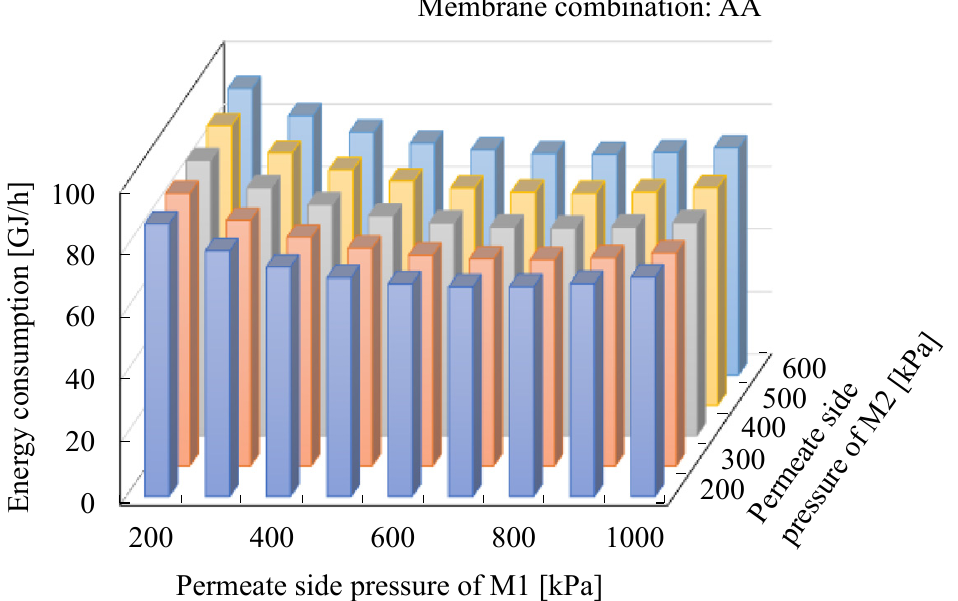
Figure A1. Energy consumption of AA at different permeate-side pressures of M1 and M2.